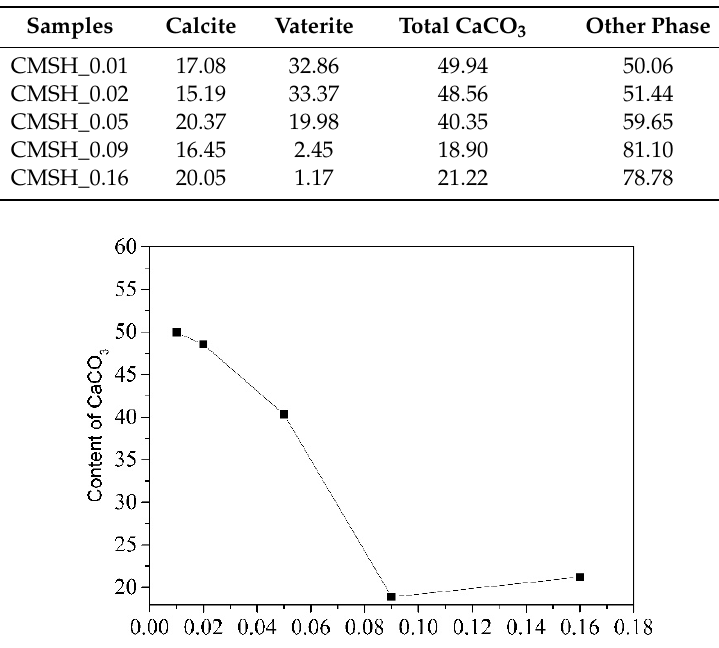
Figure 8. XRD analysis of C-(M)-S-H after carbonation for 28 days. Table 5. The e ff ect of Al / Si ratio on the content of calcite and vaterite.